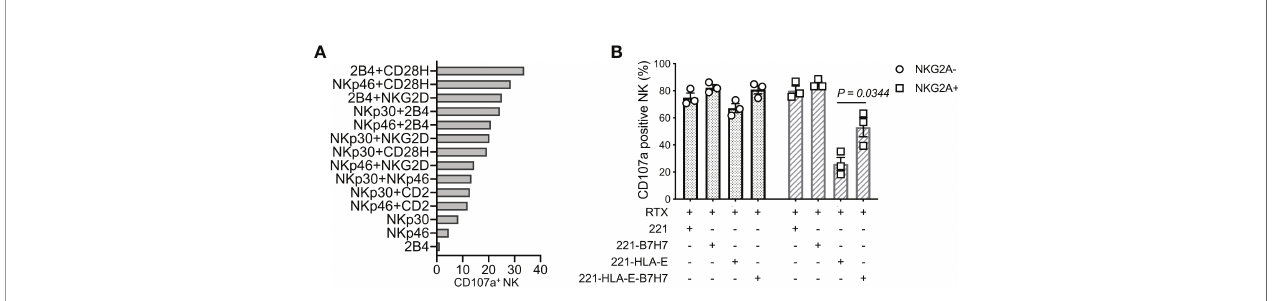
FIGURE 1 | NK cell degranulation triggered by the synergy of receptors CD28H and 2B4. (A) Degranulation of resting human NK cells induced by crosslinking combinations of NK-cell activating receptors. Crosslinking was performed in a redirected cytotoxicity assay using P815 cells in the presence of antibodies for the indicated activating receptors (n=2). (B) Degranulation of resting NK cells in the presence of rituximab (RTX) and untransfected 221 cells or transfected 221 cells that express B7H7, HLA-E, or